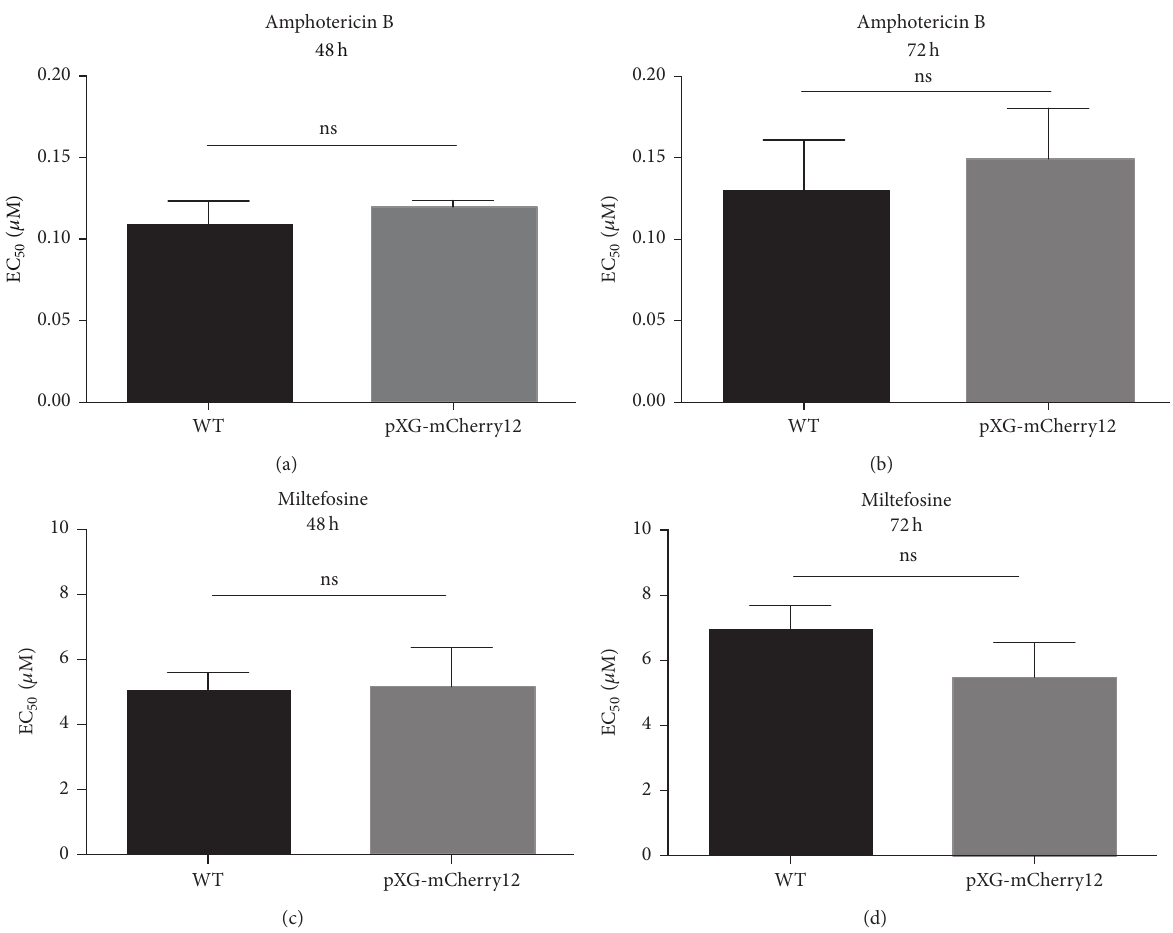
Figure 3: pXG-mCherry12 transfected parasites display similar EC 50 values against both reference drugs: miltefosine and amphotericin B. (a and b) Amphotericin B EC 50 values after 48 and 72 h exposure. (c and d) Miltefosine EC 50 values after 48 and 72 h exposure. Bars indicate the mean ( ± SEM) from three independent experiments.